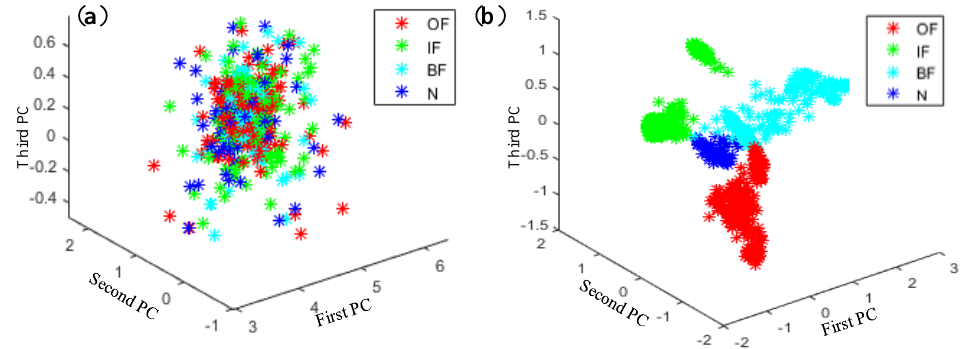
Figure 13. Feature visualization of signals under various fault types: ( a ) raw data features and ( b )